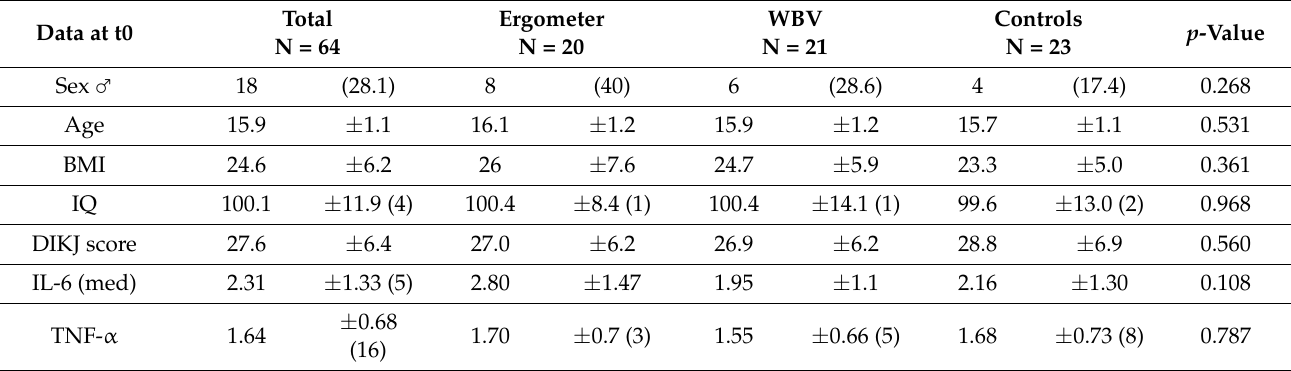
Table 2. Demographic and clinical characteristics at t0 and